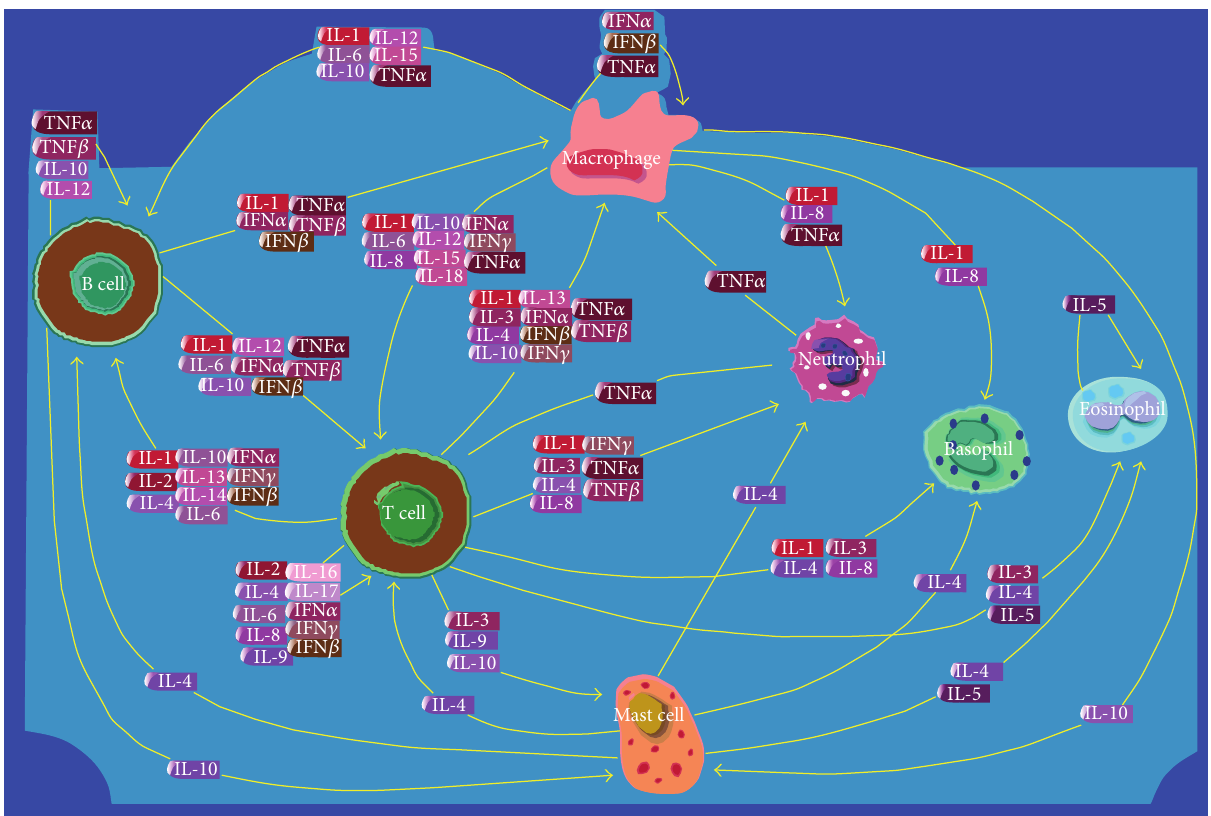
Figure 2: IL-1F11 is a recently identified member of the IL-1 family cytokines which stimulate a broad inflammatory response and promotes the recruitment of neutrophils to the site of infection. IL-1F11 =